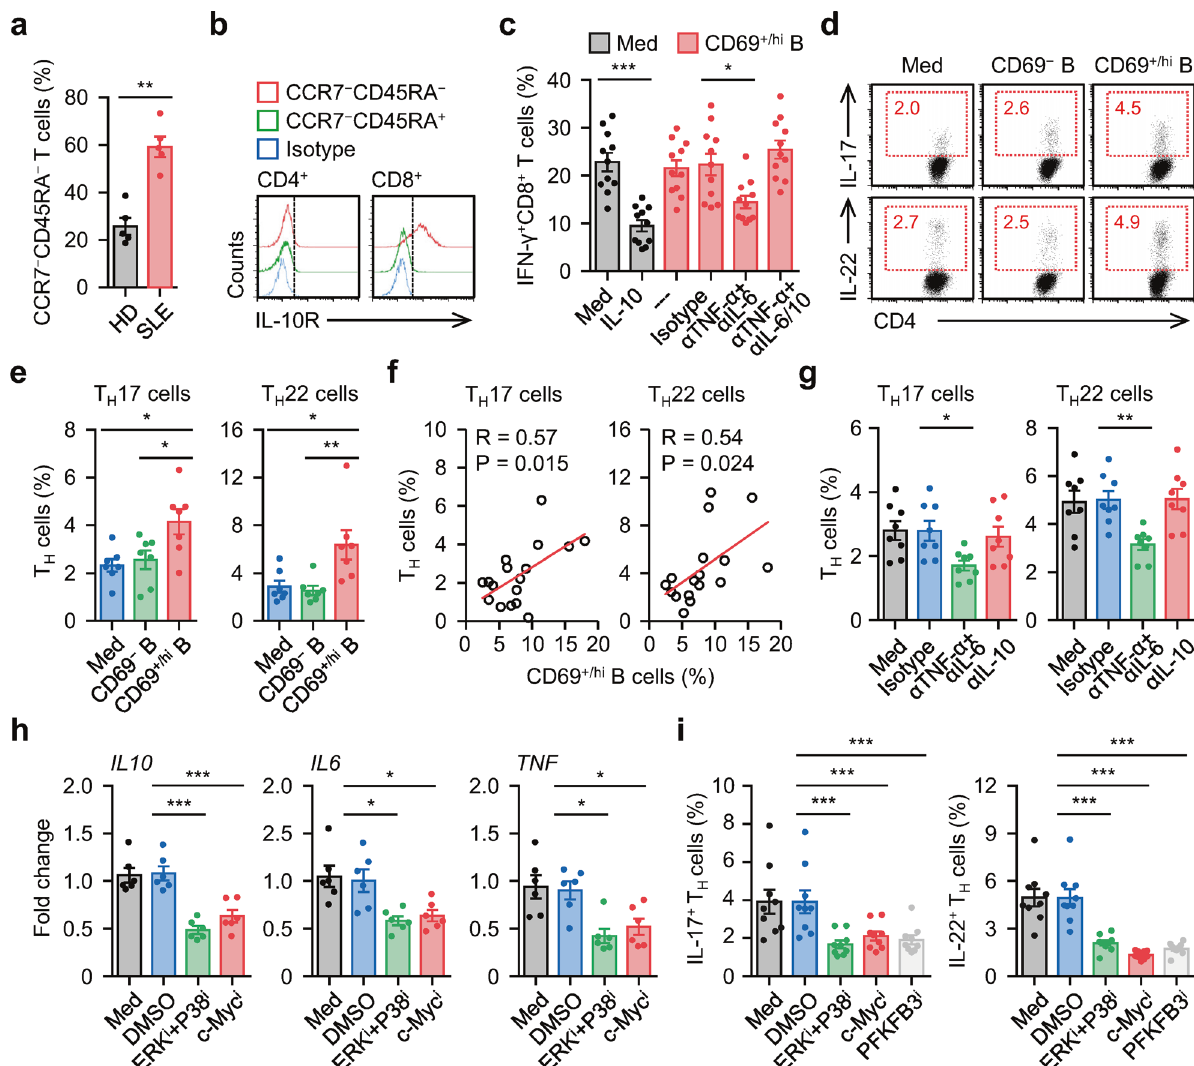
Fig. 6 Targeting c-Myc-elicited glycolysis abrogates in fl ammatory B reg cell mediated pathogenic response a , b FACS analysis of CCR7 − CD45RA − effector memory cells T cells in circulating T cells ( a ) and IL-10R expression ( b ) on effector memory T cells in blood samples from 5 healthy donors and 5 untreated SLE patients. c Puri fi ed T cells from SLE patients were cultured in medium, treated with recombinant human IL-10, or cocultured with CD69 + /hi B cells in the presence of isotype control, anti-TNF- α antibody plus anti-IL-6 antibody, or anti-TNF- α antibody plus anti-IL-6 antibody plus anti-IL-10 antibody for 7 d. IFN- γ expression in CD8 + T cells was examined using FACS ( n = 11). d , e Puri fi ed T cells from SLE patients were left untreated or cultured with CD69 − B cells or CD69 + /hi B cells for 7 d. Differentiation of T H 17 and T H 22 was determined by FACS ( n = 7). Representative dotplots and statistical data were shown in d and e , respectively. f Associations of circulating CD69 + /hi B cells with circulating T H 17 and T H 22 cells in untreated SLE patients ( n = 17). g Puri fi ed T cells from untreated SLE patients were cultured with autologous CD69 + /hi B cells in the presence of isotype control, anti-TNF- α antibody plus anti-IL-6 antibody, or anti-IL-10 antibody for 7 d. Differentiation of T H 17 and T H 22 was determined by FACS ( n = 8). h , i Puri fi ed CD69 + /hi B cells from SLE patients were cultured in medium or pretreated with DMSO, inhibitor against c-Myc, PFKFB3, or ERK plus P38. Thereafter, the cells were incubated with autologous T cells for 7 d. Cytokine expression in B cells ( h ) and differentiation of T H 17 and T H 22 ( i ) was measured by real-time PCR and FACS ( n = 6 for h ; n = 9 for i ). Data were acquired from more than four independent experiments and shown as means ± SEM. Pearson ’ s correlation analysis for f , signi fi cance was determined with Student ’ s t test ( a ) or one-way ANOVA test ( c , e , g – i ). * p < 0.05, ** p < 0.01, *** p <